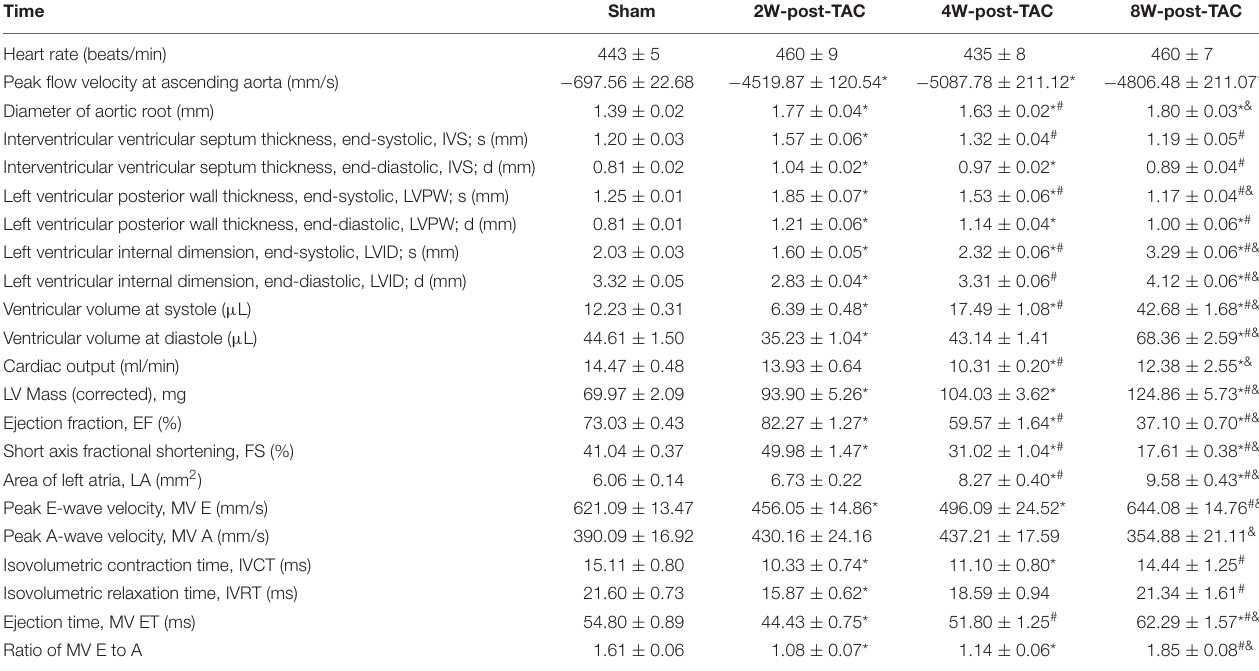
TABLE 1 | Echocardiographic